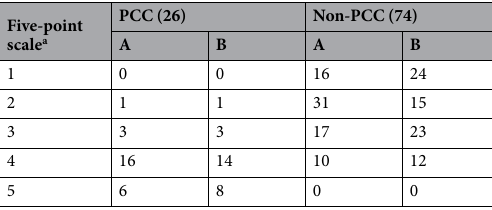
Table 3. Film reading results of doctor A and B. Note: a, likelihood of a PCC nodule in each patient using a five- point scale as follows: 1, definitely non-PCC; 2, probably non-PCC; 3, indeterminate; 4, probably PCC; and 5, definitely PCC. PCC, peripheral cholangiocarcinoma.